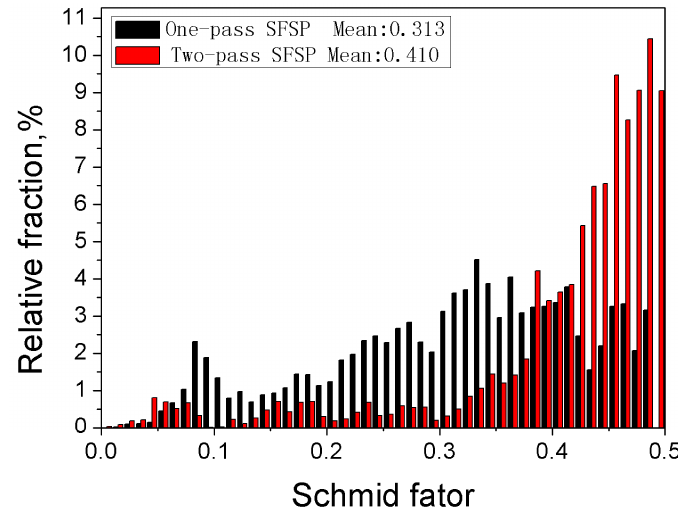
Figure 11. The relative fraction of any orientation factor accounts for all basal texture of SFSP samples.